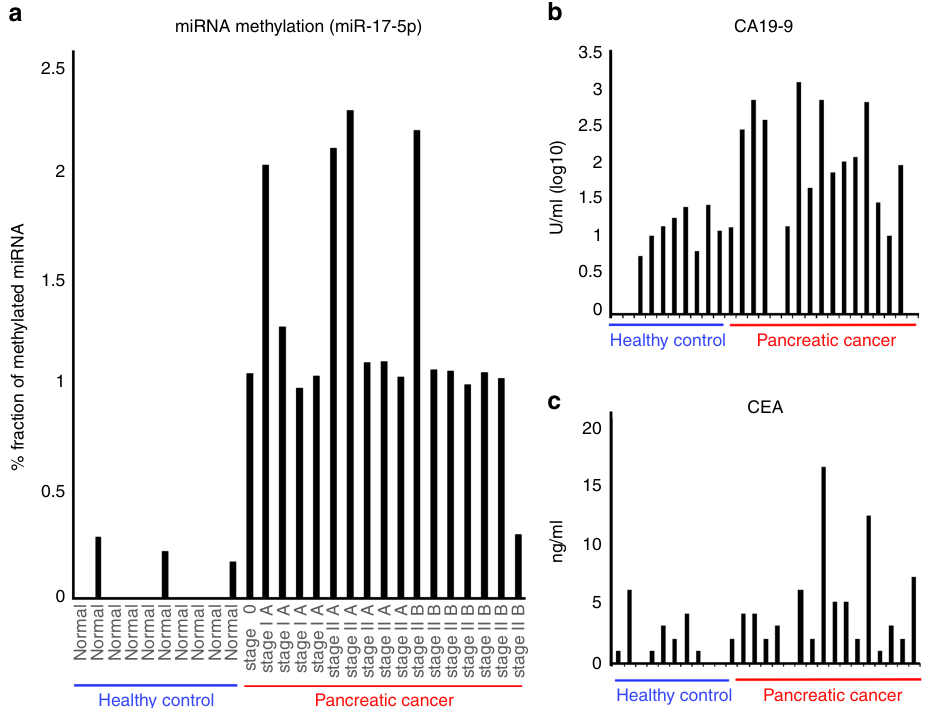
Fig. 4 Diagnostic value of methylated miRNA in early-stage pancreatic cancer. a Left, bar graph showing the fraction of methylated miRNA of miR-17-5p in serum from pancreatic cancer patients ( n = 17) and healthy controls ( n = 10). The clinical stages of pancreatic cancer are indicated at the bottom. Expression below the detection limit is shown as zero. Right, quantitative analysis of carbohydrate antigen (CA19-9) ( b ) and carcinoembryonic antigen (CEA) ( c ) expression in the same set of samples. See Supplementary Table 5 for detailed clinicopathological information of each accession code GSE119014; Microarray data for Supplementary Fig. 4 have been deposited in the NCBI GEO data set with accession code GSE134794. Public datasets used in this study can be found in GEO under the accession numbers: GDS4103 (https://www.ncbi.nlm.nih.gov/geo/query/acc.cgi?acc = GSE15471), and GDS4382 (https://www.ncbi.nlm.nih.gov/geo/query/acc.cgi?acc = GSE32323). X-ray structure used in this study can be found in PDB ID: 4OLB and 4W5N2 (http://www. rcsb.org/structure/4W5N).